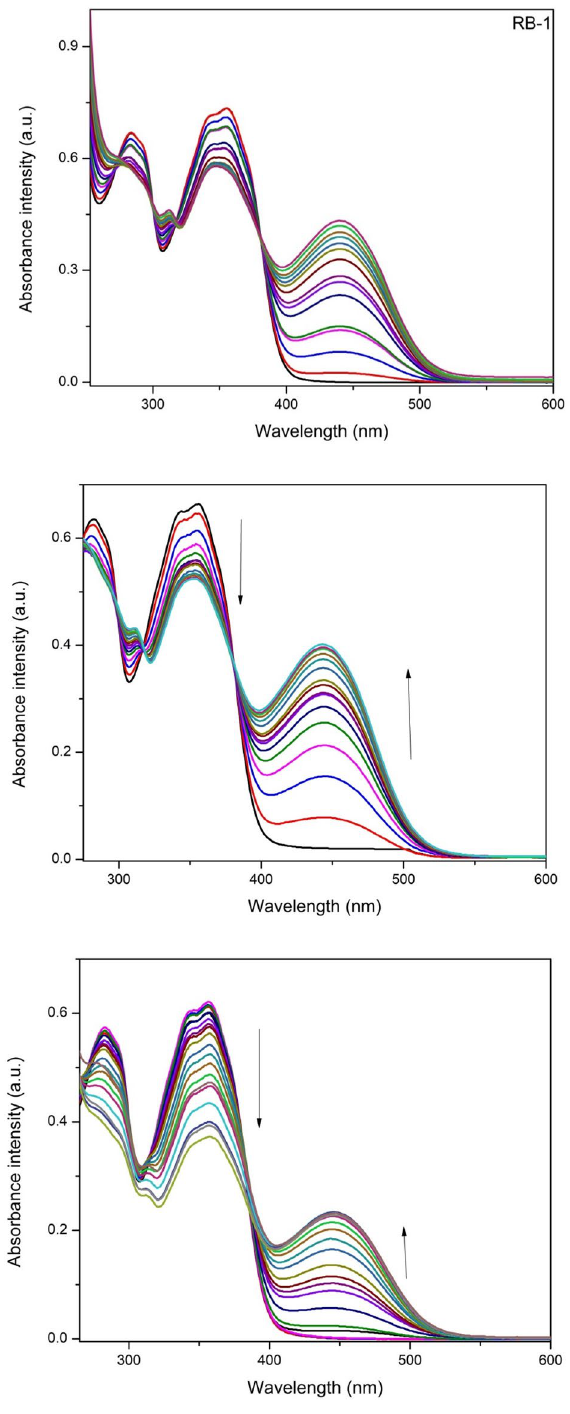
Figure 3. UV–Vis titration spectra of chemosensors RB-1, RB-2 and RB-3 in CH 3 CN after addition of CN ions (12